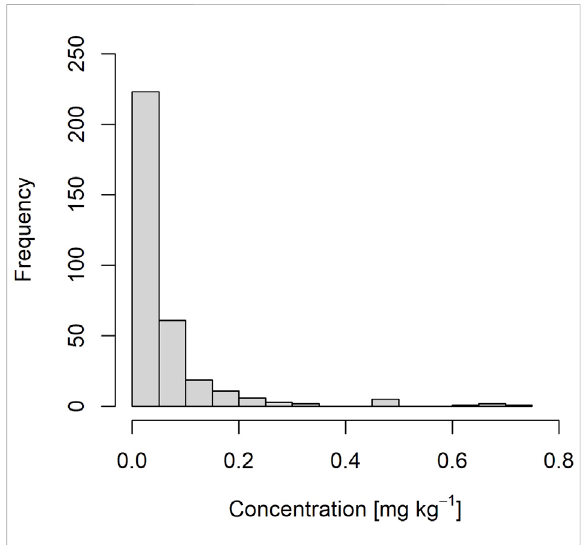
FIGURE 2 Distribution of all detected residue concentrations